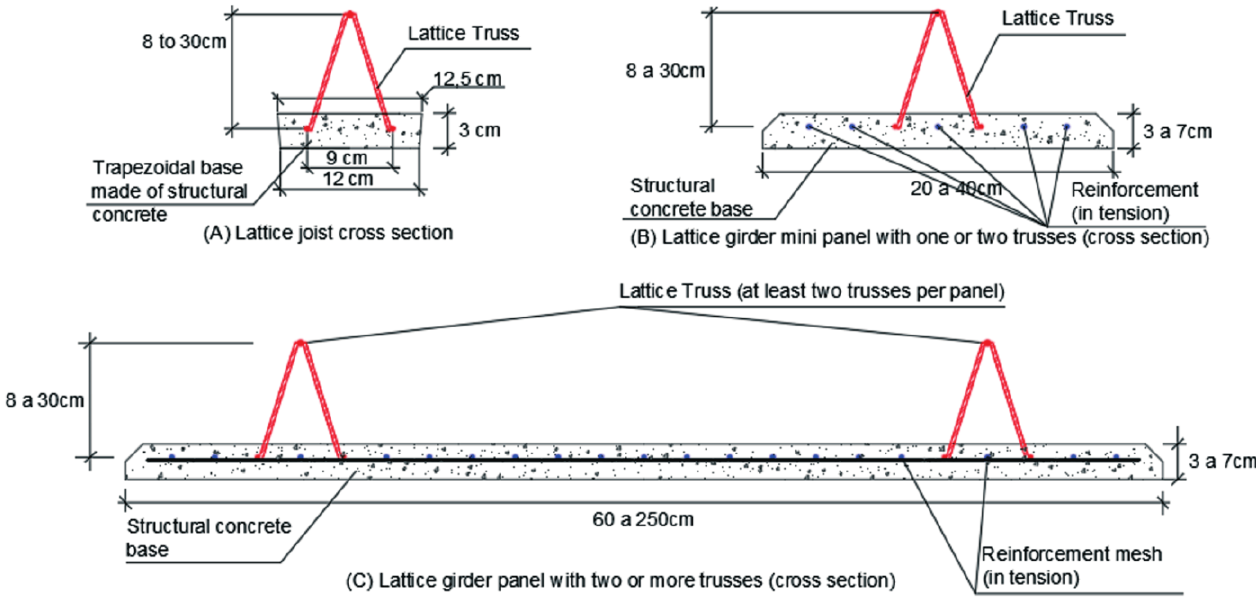
Lattice girder joist and lattice girder panels (cross section scheme) Source: Adapted from SARTORTI et al